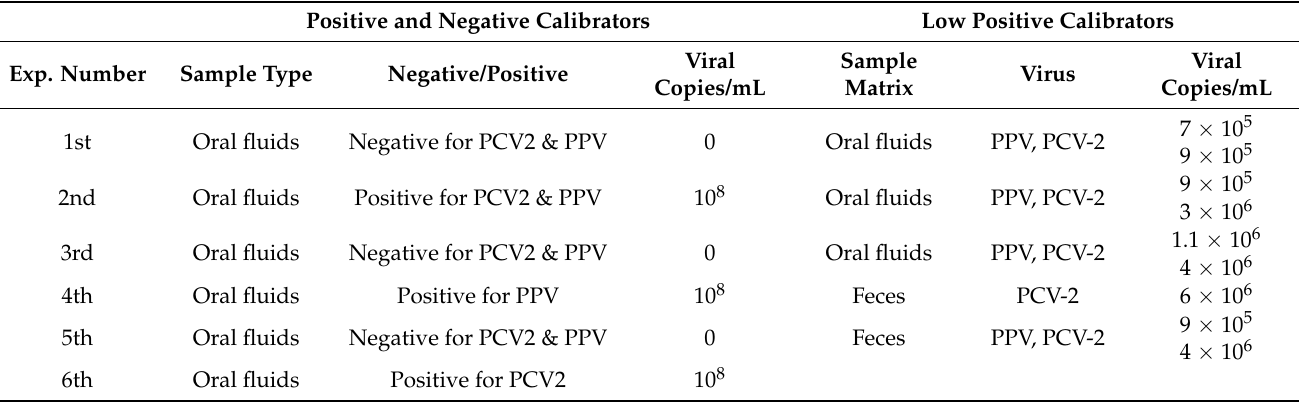
Table 3. Calibrators included in the calculation of TP, TN, FP, and FN.